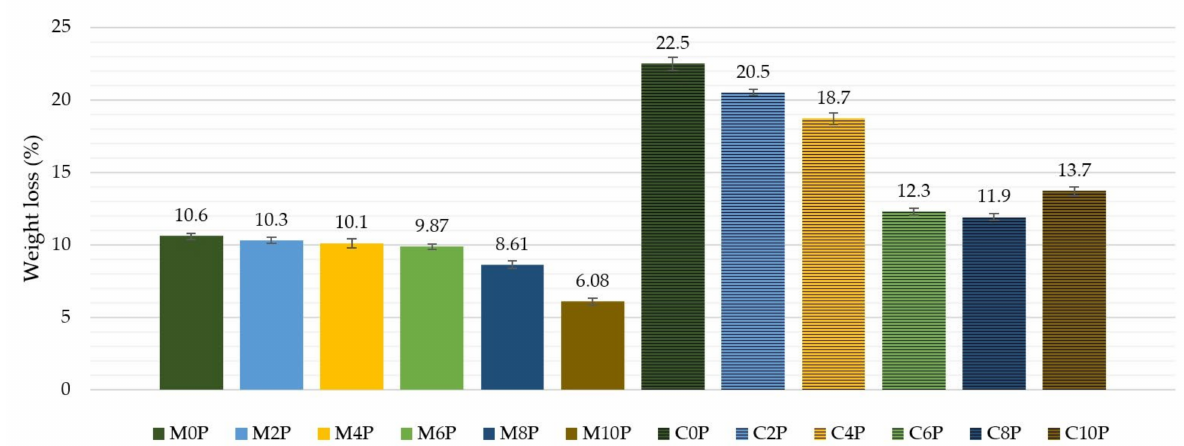
Figure 6. Weight loss (wt%) of matrices and composites after 800 ◦ C/1h exposure.